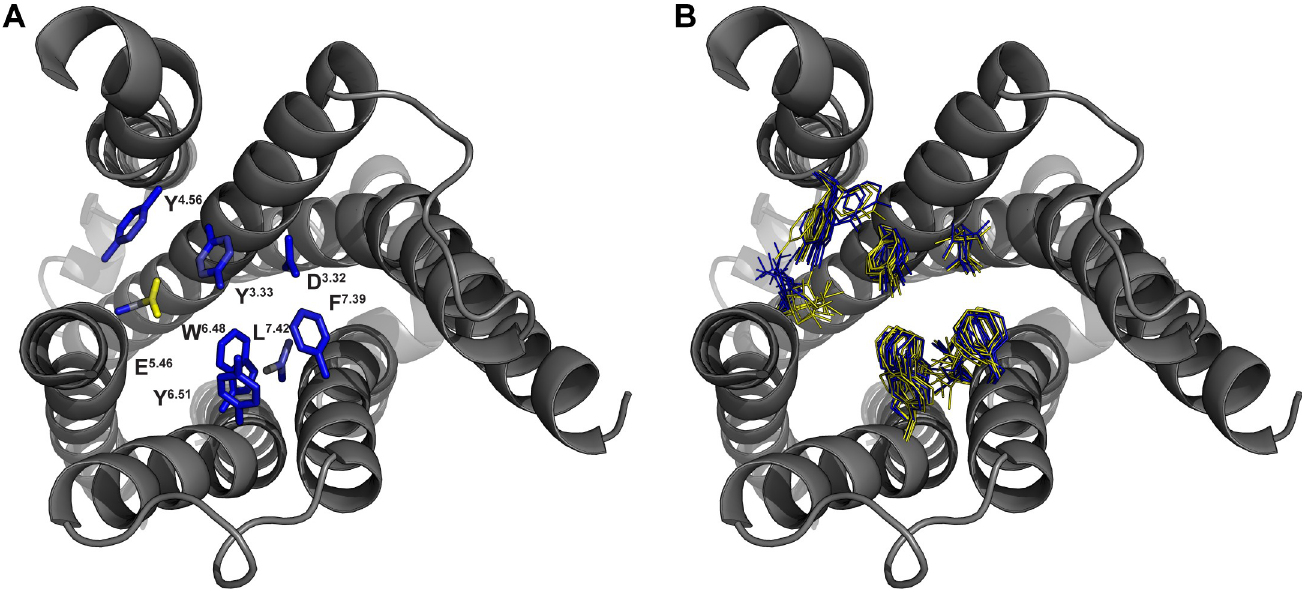
Fig 2. Best and worst scored homology models show distinct structural differences. Top view onto the orthosteric binding pocket of H 3 R. Extracellular loop 2 is not shown for sake of clarity. (A) Structural differences were analyzed by calculating the difference in average side chain atom position of 10 highest and 10 lowest ranked models. Blue color indicates low difference, yellow high difference. (B) Sidechain conformations of 10 highest and 10 lowest ranked homology models. Yellow–high ranked models, blue–low ranked models.